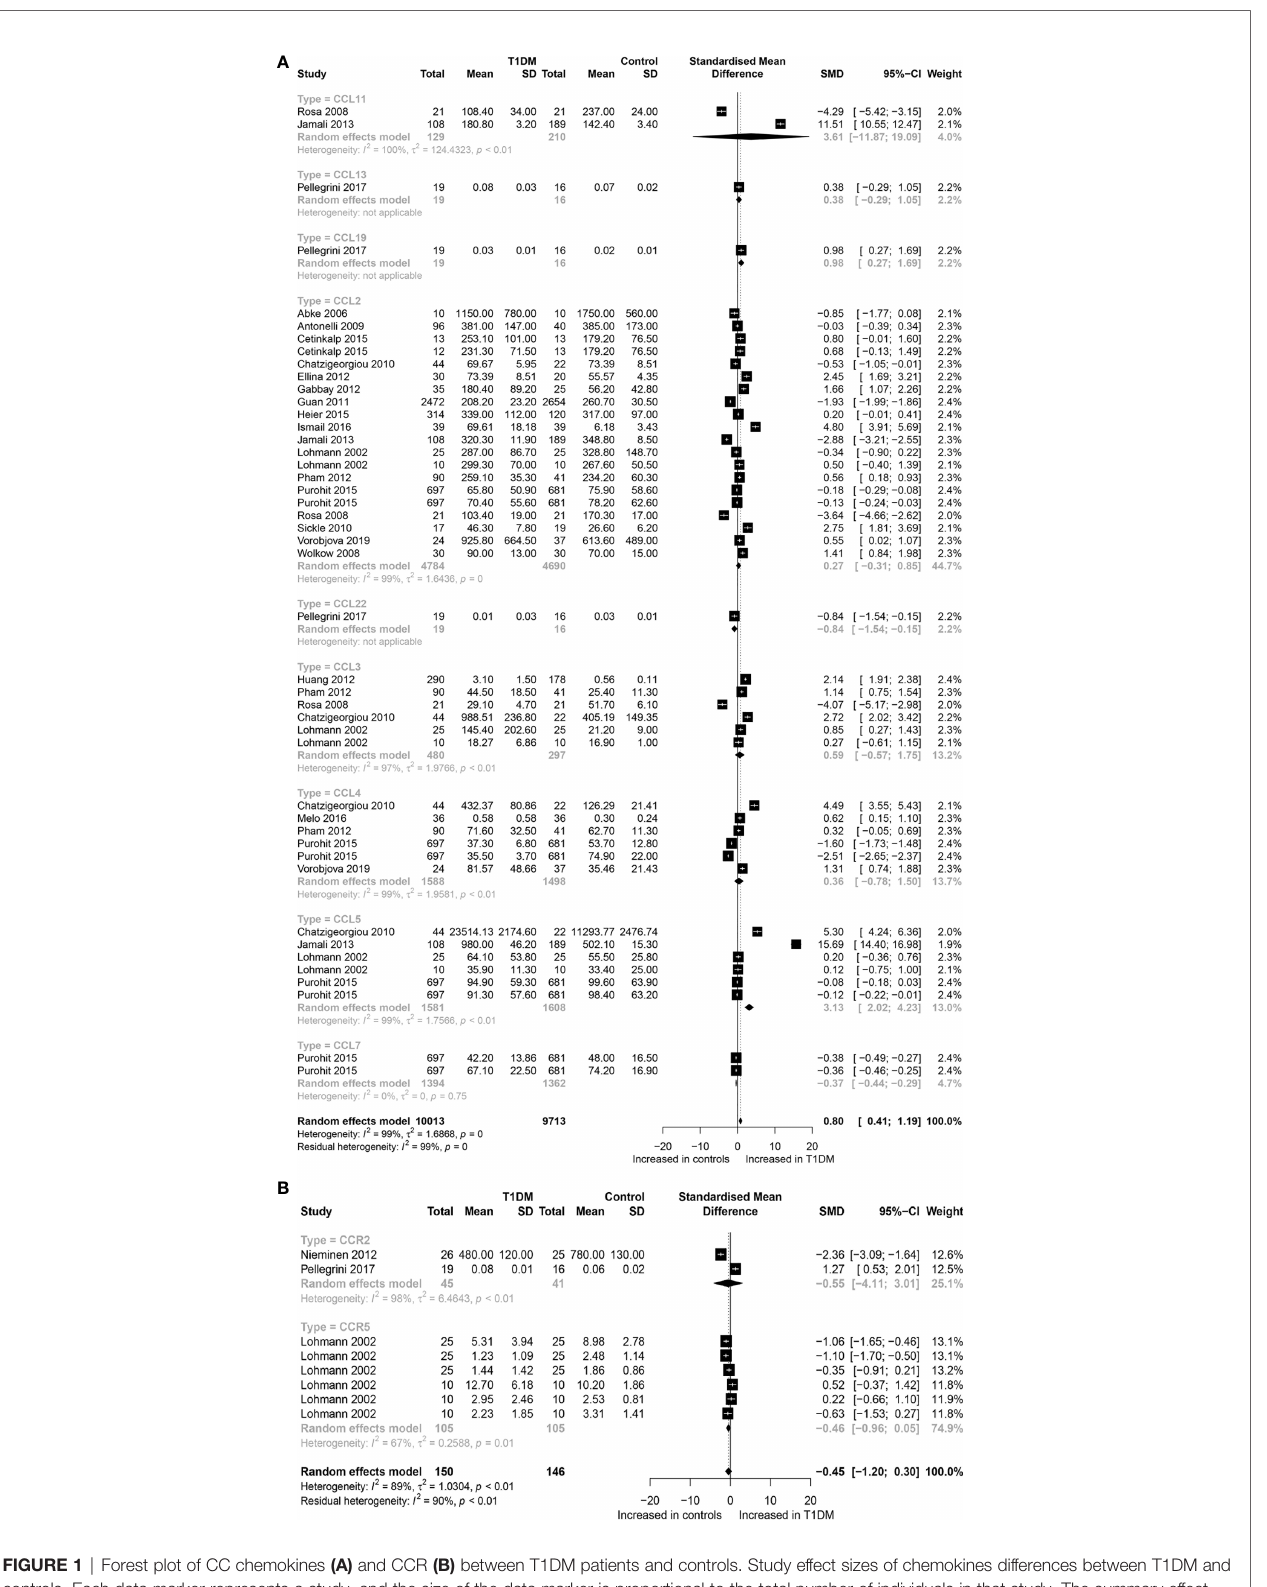
FIGURE 1 | Forest plot of CC chemokines (A) and CCR (B) between T1DM patients and controls. Study effect sizes of chemokines differences between T1DM and controls. Each data marker represents a study, and the size of the data marker is proportional to the total number of individuals in that study. The summary effect size for each chemokines is denoted by a diamond. T1DM, Type 1 diabetes mellitus; CCR, CC chemokines receptor; SMD, standardized mean